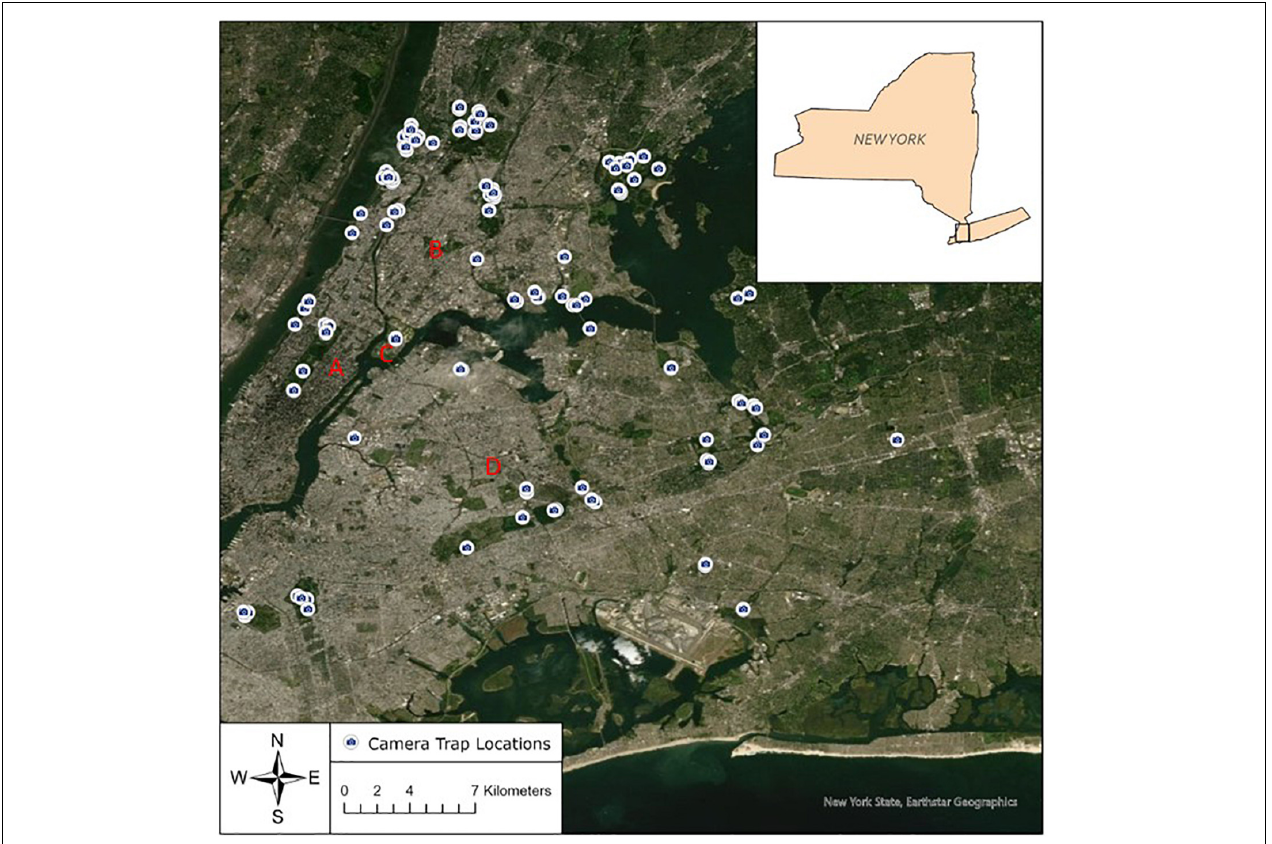
FIGURE 1 | Map of camera locations across 31 greenspaces in which mammals were surveyed in the New York metropolitan area, 2015–2019. A = Manhattan; B = Mainland (Bronx/Westchester); C = Randall’s Island; D = Long